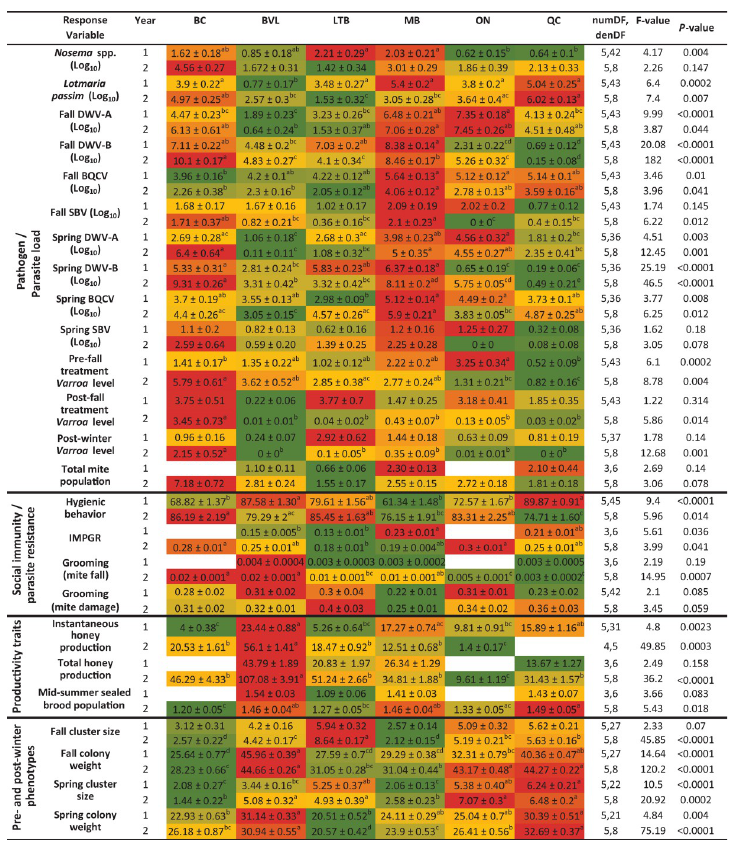
Fig 2. Pathogen/parasite load and phenotypic assessment value averages ( ± SEM) for each location during the experimental years of 2016–2017 (year 1) and 2017–2018 (year 2). Pathogen load averages for viruses, Nosema spp., and Lotmaria passim are reported on the same scale the data was analysed (log 10 ). Total mite population data was divided by 1 000 and mid-summer sealed brood population by 10 000. All other variables are on their original scale. Statistically significant differences of response variables among locations are denoted with different letters. A color gradient was used to represent relative mean changes within each experimental year (not statistical differences), for each variable, from green (lowest) to red (highest). Measurement units are as follows: Nosema , spores/bee; Lotmaria passim and viruses, genome copies/bee; Varroa level, mites/100 bees; total mite population, total count; hygienic behavior, percentage of cells removed after 24 hrs; instantaneous mite population growth rate (IMPGR), mite growth rate per week; grooming (mite drop), proportion of mite fall per day; grooming (mite damage), proportion of damaged mites; colony weight, instantaneous and total honey production, weight (kg); mid-summer sealed brood population, total number of worker sealed brood cells; cluster size, total full frame spaces. Blank cells in year 1 ( e . g ., BC total honey production) are a result of unmeasured phenotypes in the standard management